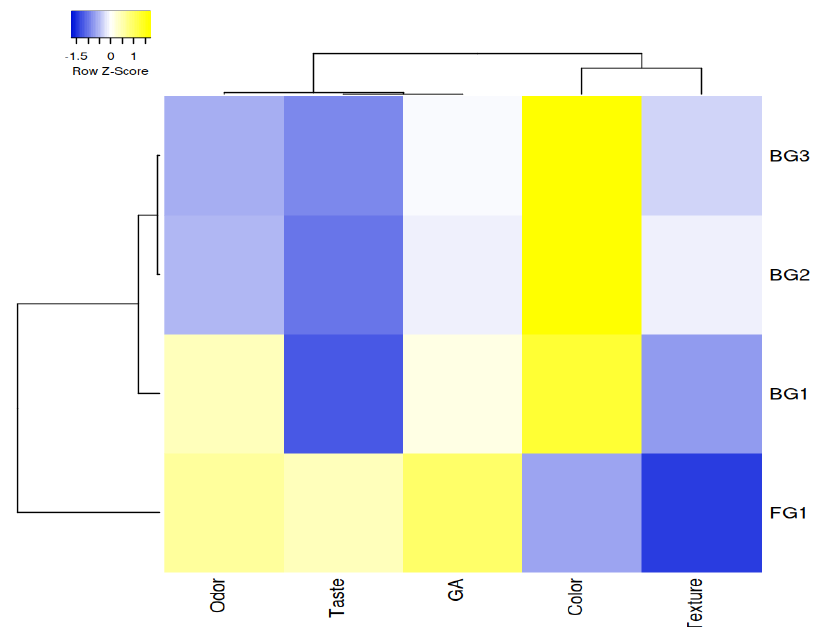
Figure 3. Cluster analysis of heatmap showing the relationship between physicochemical parame- ters and garlic treatments (The X and Y axes represent the physicochemical and garlic treatments, respectively (the intensity of the yellow and blue color represents from higher to lower correlation levels).